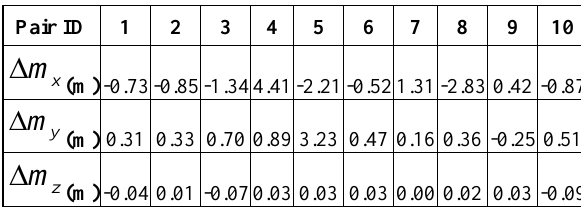
Table 1. Check planes normal vectors differences